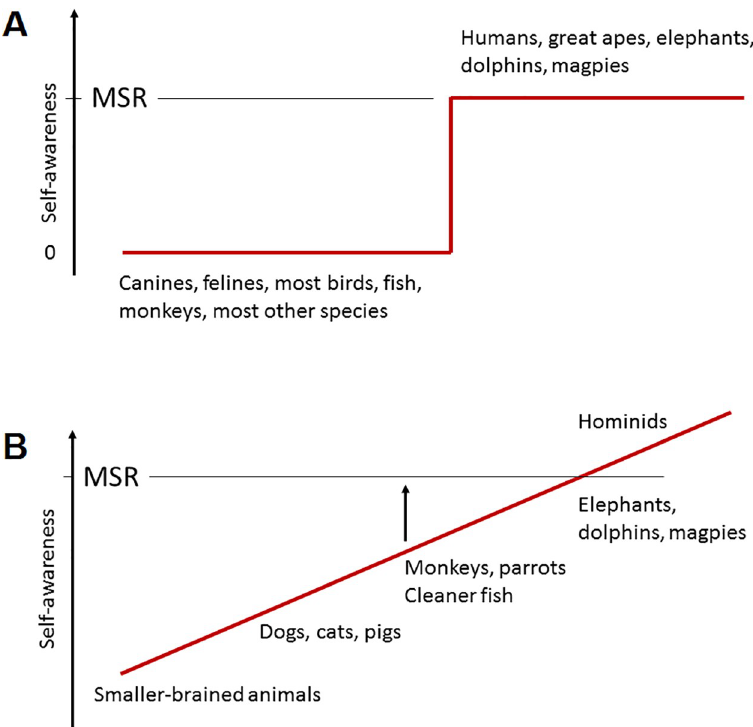
Fig 3. Two different perspectives on the evolution of self-awareness. In the traditional binary model (A), species showing MSR possess a self-concept, whereas all other species do not. The gradualist view (B), in contrast, assigns the highest level of self-awareness to hominids, who spontaneously explore and play with their reflection and care about their appearance, and assigns intermediate or lower levels to other species, but no zero level because all animals need a self-concept. Reactions to mirrors range from permanent confusion about one’s reflection to a certain level of understanding of how mirrors operate (e.g., using them as tools) and only brief or no confusion between one’s reflection and a stranger. Some species, such as macaques and perhaps cleaner fish, seem to possess this intermediate level and can therefore, with the aid of training and/or multimodal stimulation, be "lifted" (arrow) to a level of mirror understanding closer to MSR. MSR, mirror